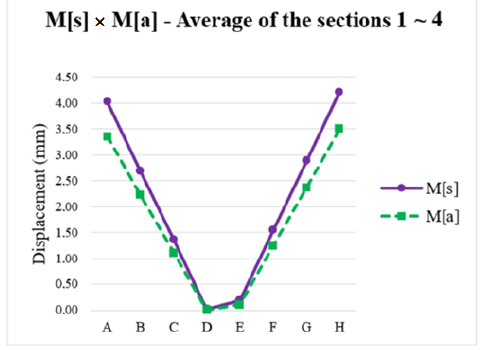
Figure 12. M[s] × M[a] Scatter plot — Sections 1 – 4.